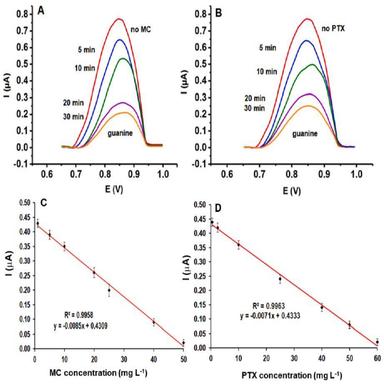
Interactions of the drug molecules with dsDNA/PEDOT NEs A) MC, B) PTX (dsDNA concentration: 50 mg L− 1 , drug concentrations: 25 mg L− 1 ), Calibration plots for C) MC, D) PTX (n = 3).